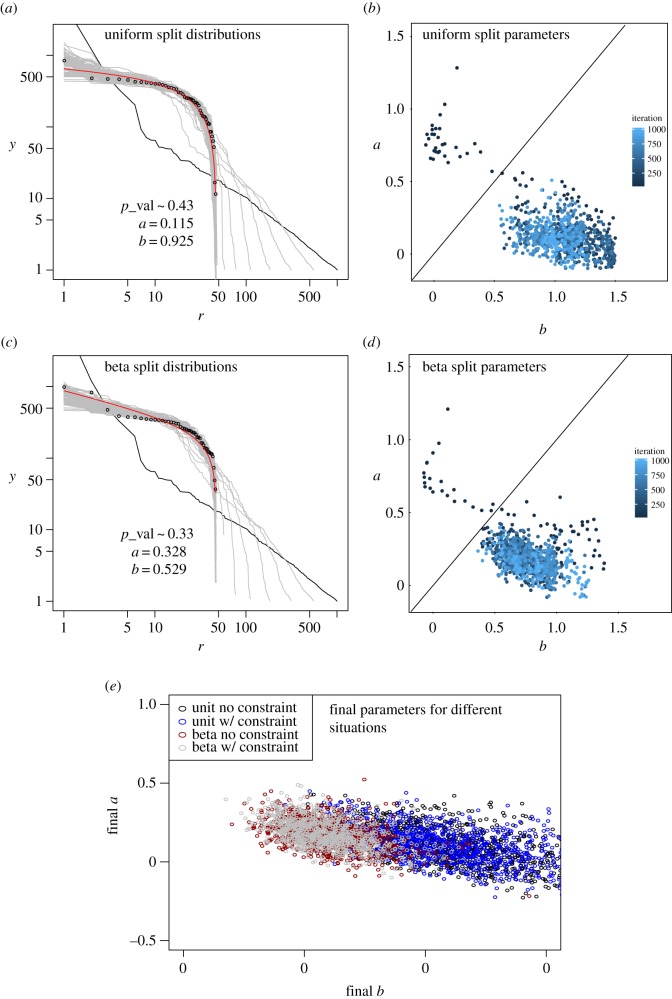
Realizations of the split–merge process in one-dimension. We see in black the initial rank-size function, in grey a sample of intermediate distributions, in circles the final distribution after 1000 iterations and in red the fitted DGBD to the final sample. The fitted parameters of the DGBD for each step of the process are also shown: (a) and (b) uniform split with spatial constraint; (c) and (d) non-uniform split with spatial constraint. We also display the p-values of the DGBD hypothesis for the final sample and fitted parameters. (e) The b,a parameters after 1000 iterations for 1000 different realization of four cases of the process.